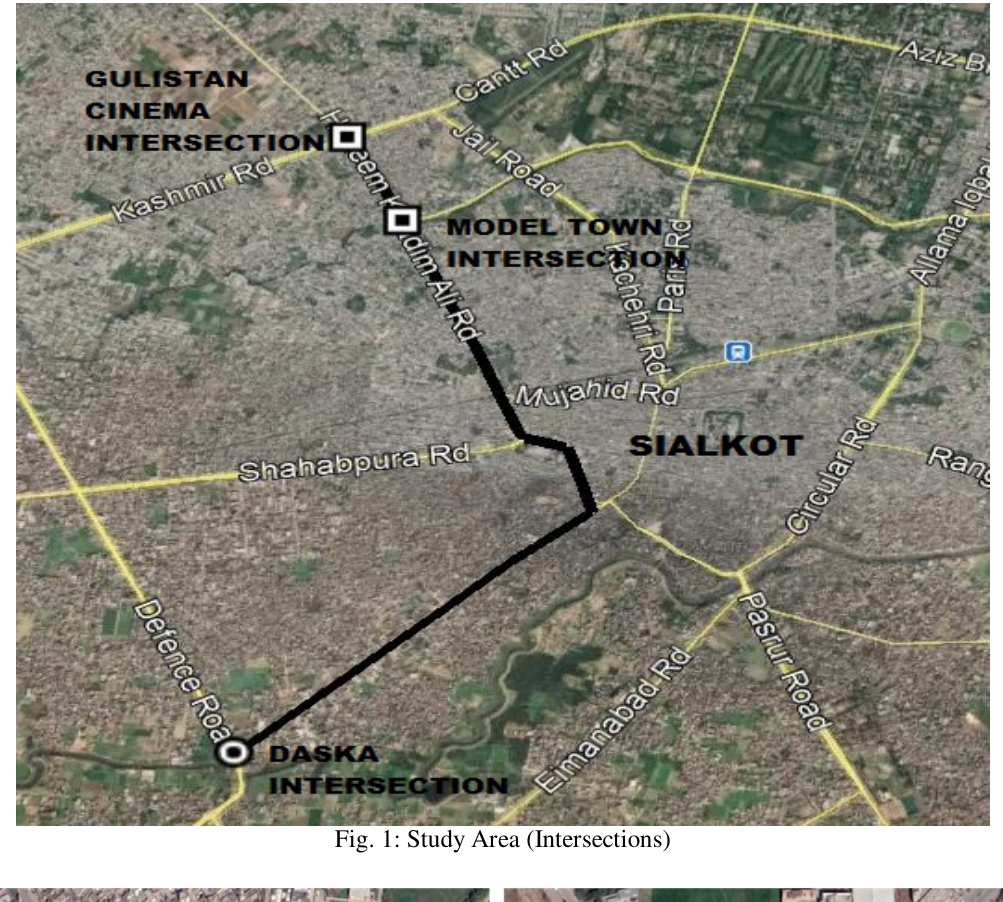
Fig. 1: Study Area (Intersections)